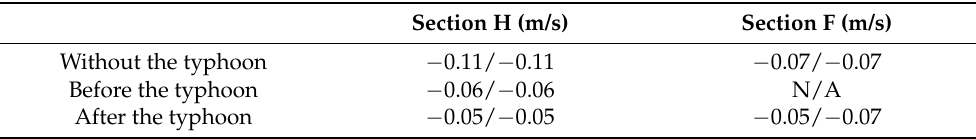
Table 4. The cross-shelf water flux per unit area (before de-tided processing/after de-tided